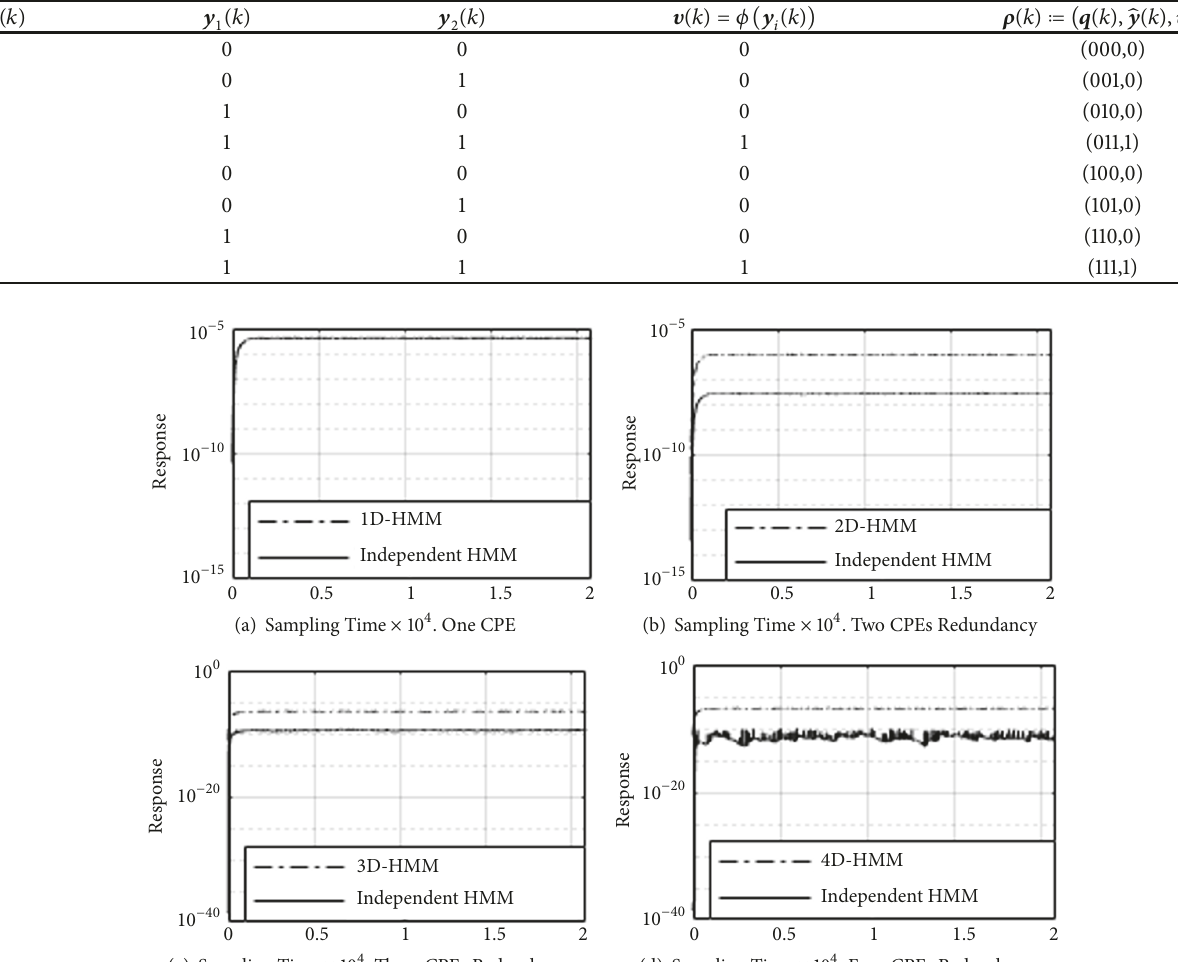
Table 1: State Table for 2 CPEs Redundant Structure of Flight Control System Subject to Environments.